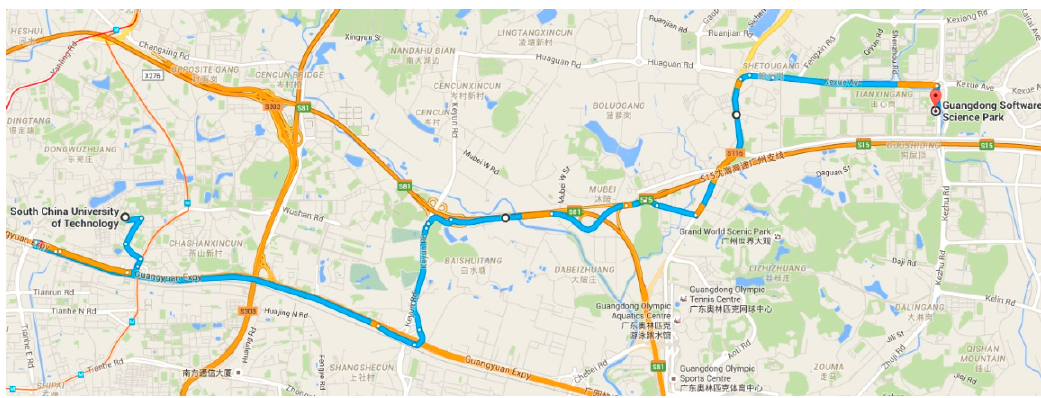
Figure 9. Route planning based on MCS.